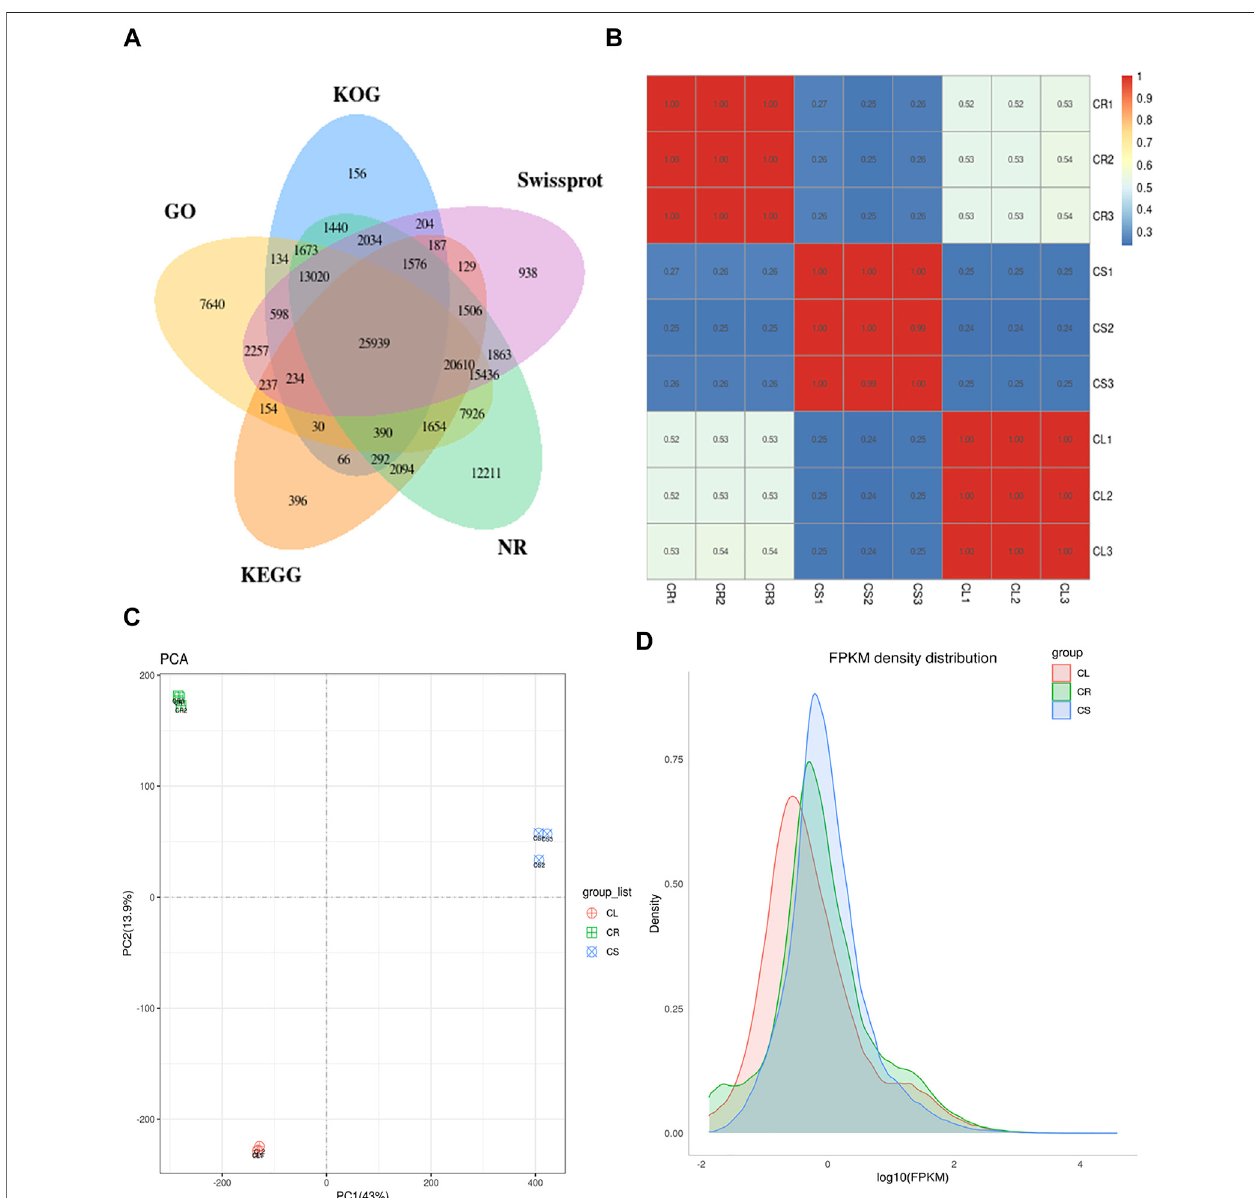
FIGURE 5 | Transcriptome analysis of C. convolvulacea leaf (CL), stem (CS), and tuber (CR). (A) Venn diagram showing annotation of the unigenes in different databases, (B) Pearson ’ s correlation coef fi cient, (C) principal component analysis, and (D) FPKM density distribution graph.